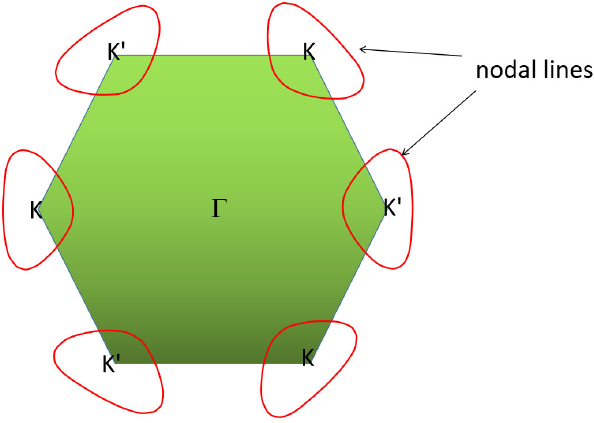
Figure 7. Illustration of one pair of nodal lines (highlighted by red lines) in the k z = 0 plane.